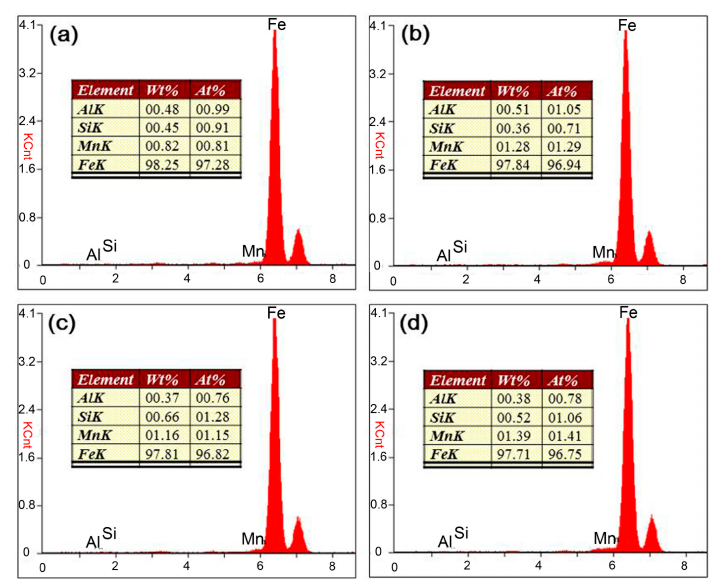
Figure 7. Energy dispersive X-ray spectroscopy (EDS) component analysis of different zones within the weld, ( a ) laser zone of root layer; ( b ) arc zone of root layer; ( c ) overlapped interlayer; ( d ) filler layer.